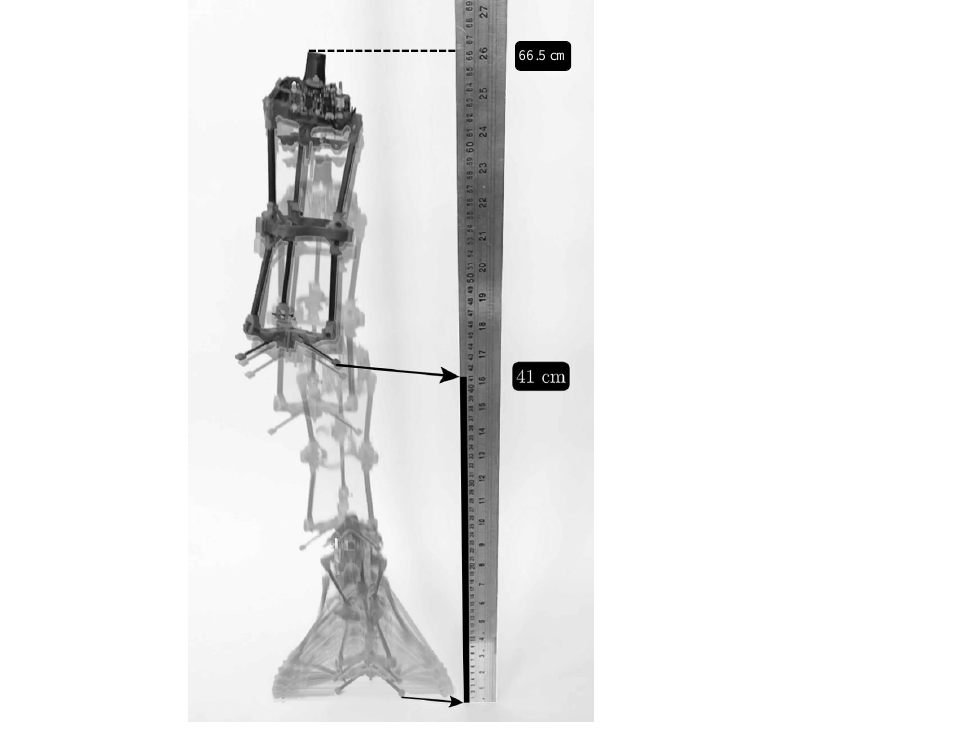
( d ) Figure 3. Jumping process of the prototype: ( a ) uncompressed state; ( b ) compressed state; ( c ) take- off state; ( d ) landing state. 3. Referred Simulation Model The jumping robot model for landing simulation will be referred from the MACE space robotics team. The simulation model is the analog of the simulated object or its structural form and it can be a physical model or a mathematical model [18]. In this paper, the referred simulation model prototype is a physical model. The researchers generated a